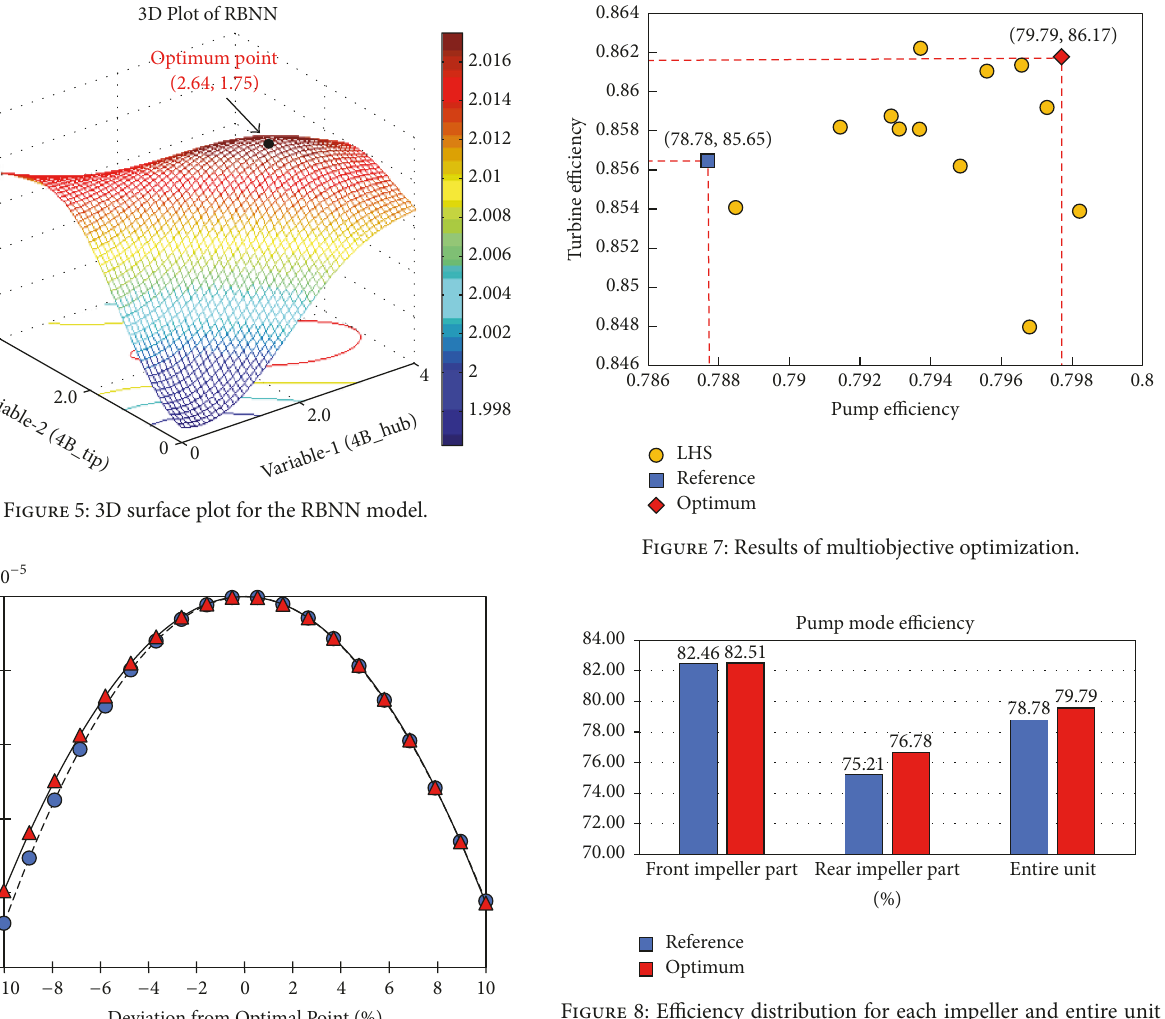
Figure 8: Efficiency distribution for each impeller and entire unit on the pump